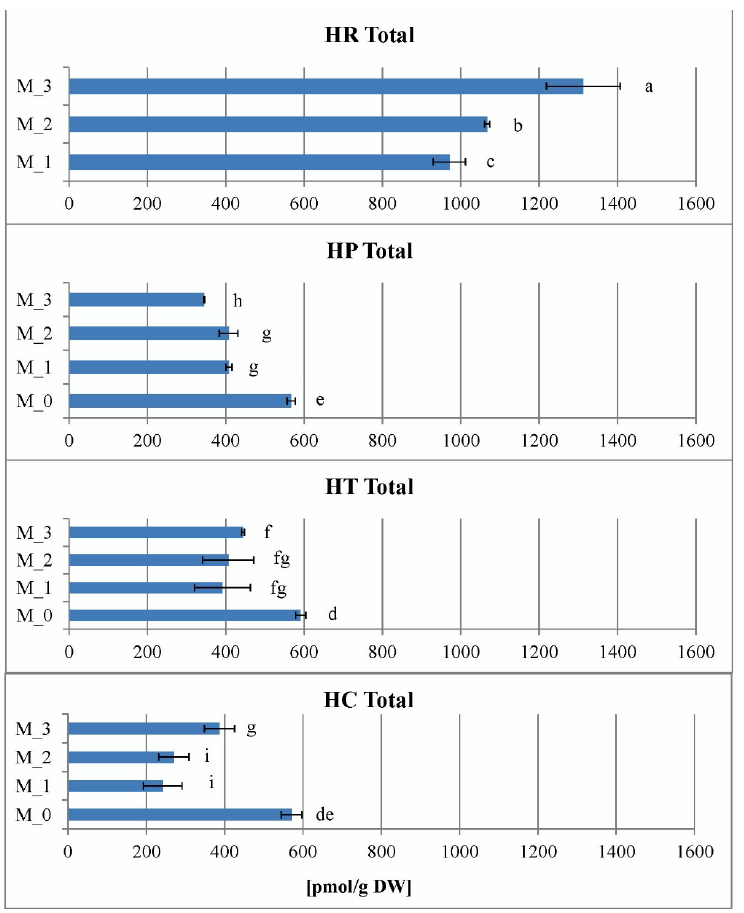
Figure 9 . Total sum of cytokinin ribosides in the four Hypericum species in M_0—PGR-free, M_1— 0.2 mg/L BA, M_2—0.2 mg/L BA + 0.1 mg/L IBA and M_3—0.1 mg/L BA + 0.2 mg/L IBA supple- M_1—0.2 mg/L BA, M_2—0.2 mg/L BA + 0.1 mg/L IBA and M_3—0.1 mg/L BA + 0.2 mented media, HR– H. richeri Vill., HP– H. perforatum L., HT– H. tetrapterum Fries. and HC– H. calyci- num . Same letters indicate statistically non-significant and different letters indicate statistically sig- nificant differences of the mean values when comparing the parameter between all samples.